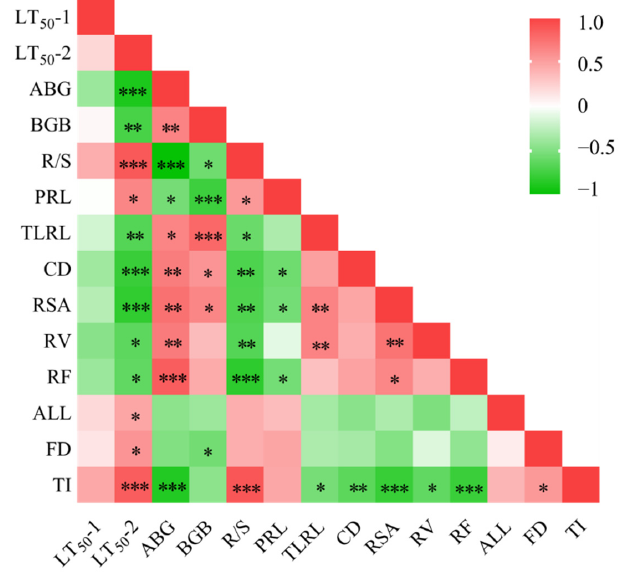
Figure 8. Pearson correlation analysis of semi ‐ lethal temperature (LT 50 ) and phenotypic traits of alfalfa under three drip irrigation depths. LT 50 − 1 , semi ‐ lethal temperature of phase 1; LT 50 − 2 , semi ‐ lethal temperature of phase 2; AGB, aboveground biomass; BGB, belowground biomass; R/S, AGB/BGB; PRL, primary root length; TLRL, total lateral root length; CD, crown diameter; RSA, root surface area; RV, root volume; RF, number of root forks; ALL, average link length; TI, topological index; FD, fractal dimension. *, ** and *** represent a significant correlation at the 0.05, 0.01 and 0.001 levels, respectively.